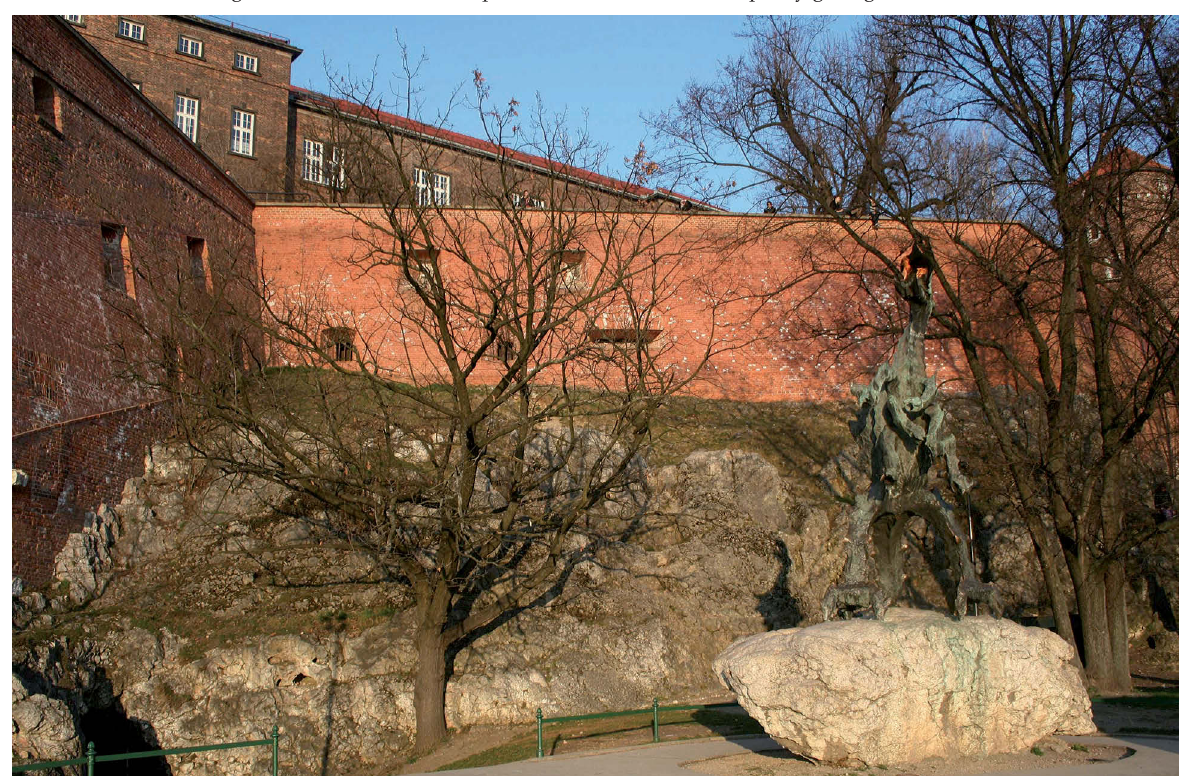
Fig. 7. Renaturalised landscape in the area of “Bonarka” quarry geological reserve